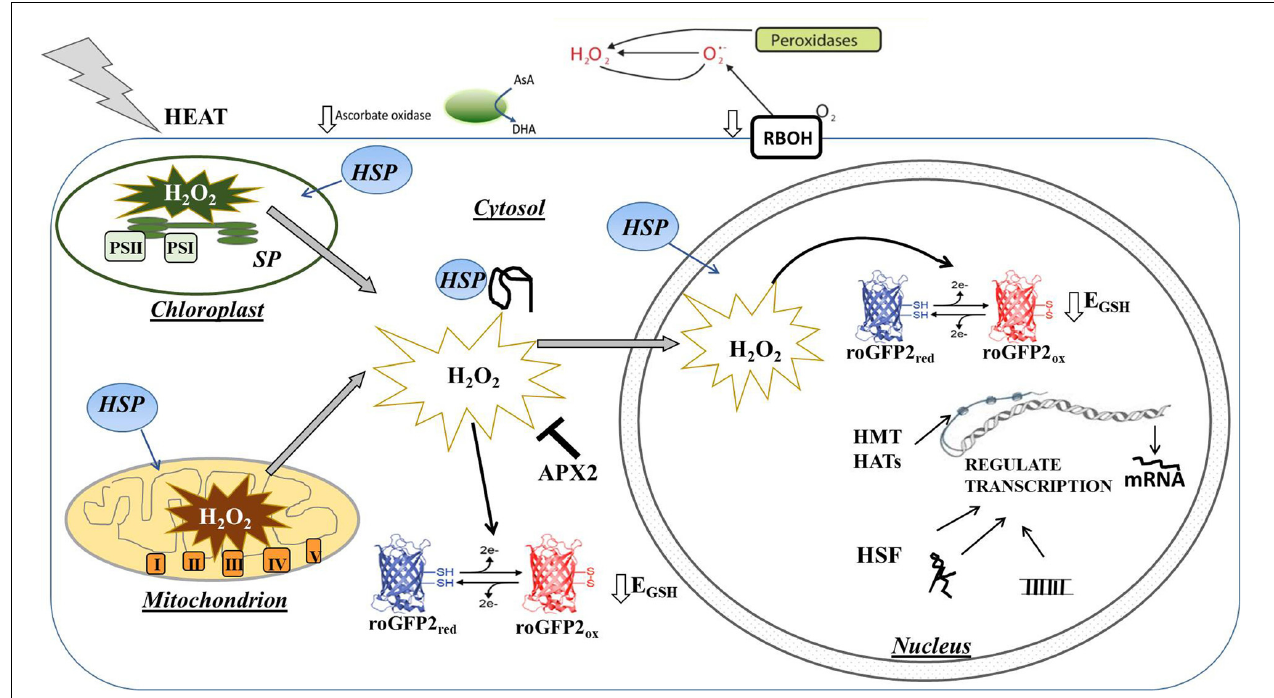
FIGURE 11 | Simplified model illustrating the effect of heat stress on H 2 O 2 production and associated oxidation of the cytosol and nucleus on the regulation of gene expression. The levels of transcripts encoding apoplastic H 2 O 2 producing enzymes such as the Respiratory Burst Homologs (RBOH) and cell wall peroxidases were decreased in response to heat, as were transcripts encoding ascorbate oxidase (AO), which catalyzes the first step of the ascorbate degradation pathway. Heat increases the production of H 2 O 2 in chloroplasts and mitchondria leading to oxidation of the cytosol and nucleus. This oxidation causes a highly specific expression of antioxidant genes such as APX2 that are important in the regulation of signal transduction, as well as heat shock factors (HSF) that regulate heat shock-induced signaling process. Transcription is also rapidly regulated by epigenetic factors such as histone methyltransferases (HMT) and histone acetyltransferases (HAT) as well as by the production of microRNAs (miRNA) and long non-coding RNA